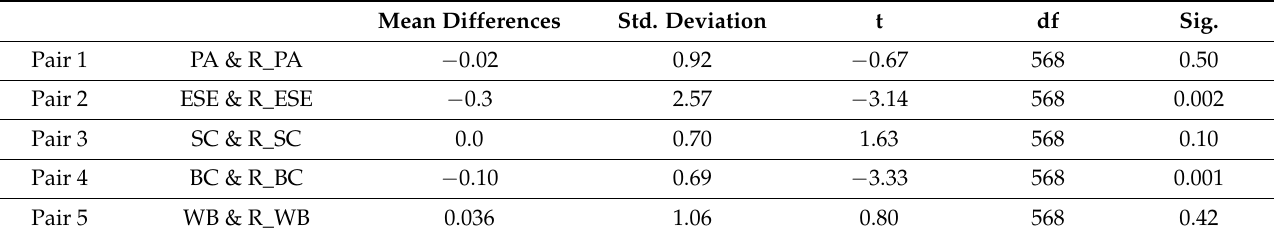
Table 2. Paired T-test.